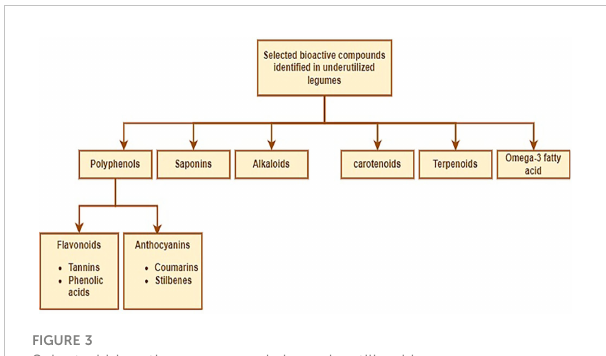
FIGURE 3 Selected bioactive compounds in underutilized